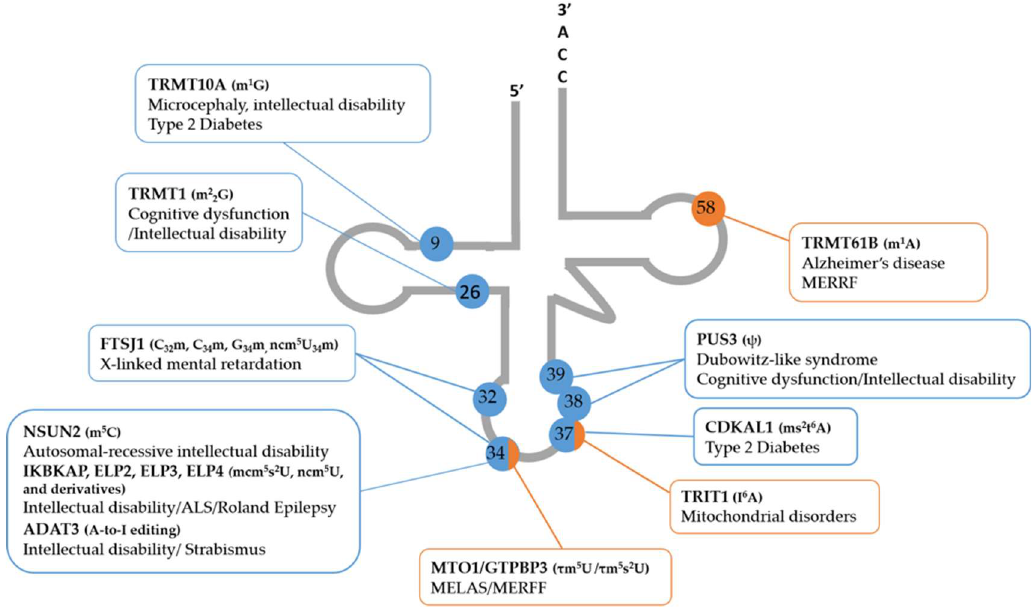
Figure 3. Identification of tRNA-modifying enzymes and respective tRNA modification sites involved in neurological and metabolic disorders. Schematic representation of the clover leaf tRNA secondary structure including tRNA-modifying enzymes (in bold), modifications (in parenthesis), and human diseases associated with cytosolic and mitochondrial tRNA defects marked in blue and orange, respectively. Abbreviations : tRNA, transfer RNA; m 1 G, 1-methylguanosine; m 22 G, N2,N2-dimethyl guanosine; Cm, 2′- O -methylcytidine; Gm, 2′- O -methylguanosine; ncm 5 Um, 5-carbamoylmethyl-2′- O - methyluridine; m 5 C, 5-methylcytosine; ncm 5 mU, 5-methoxycarbonylmethyluridine; mcm 5 s 2 U, 5- methoxycarbonylmethyl-2-thiouridine, τm 5 U, 5-taurinomethyluridine; τm 5 s 2 U, 5-taurinomethyl-2- thiouridine; I 6 A, N6-isopentenyladenosine; ms 2 t 6 A, 2-methylthio-N6-threonyl carbamoyladenosine; Ψ, pseudouridine; m 1 A, 1-methyladenosine; ALS, amyotrophic lateral sclerosis; MELAS, mitochondrial encephalomyopathy, lactic acidosis, and stroke-like episodes; MERFF, myoclonus epilepsy associated with ragged red fibers.